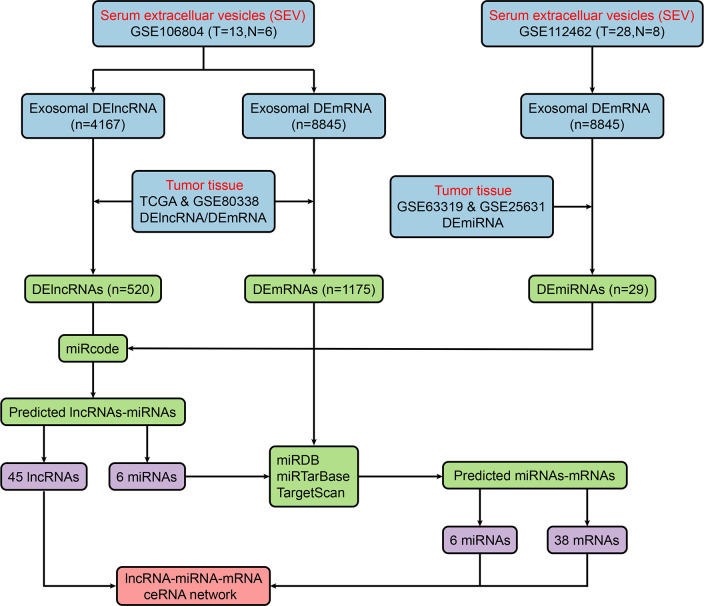
Flow chart of ceRNA network construction. ceRNA, competitive endogenous RNA; DElncRNA, differentially expressed long noncoding RNA; miRDB, miRNA database; miRNA, microRNA; mRNA, messenger RNA.